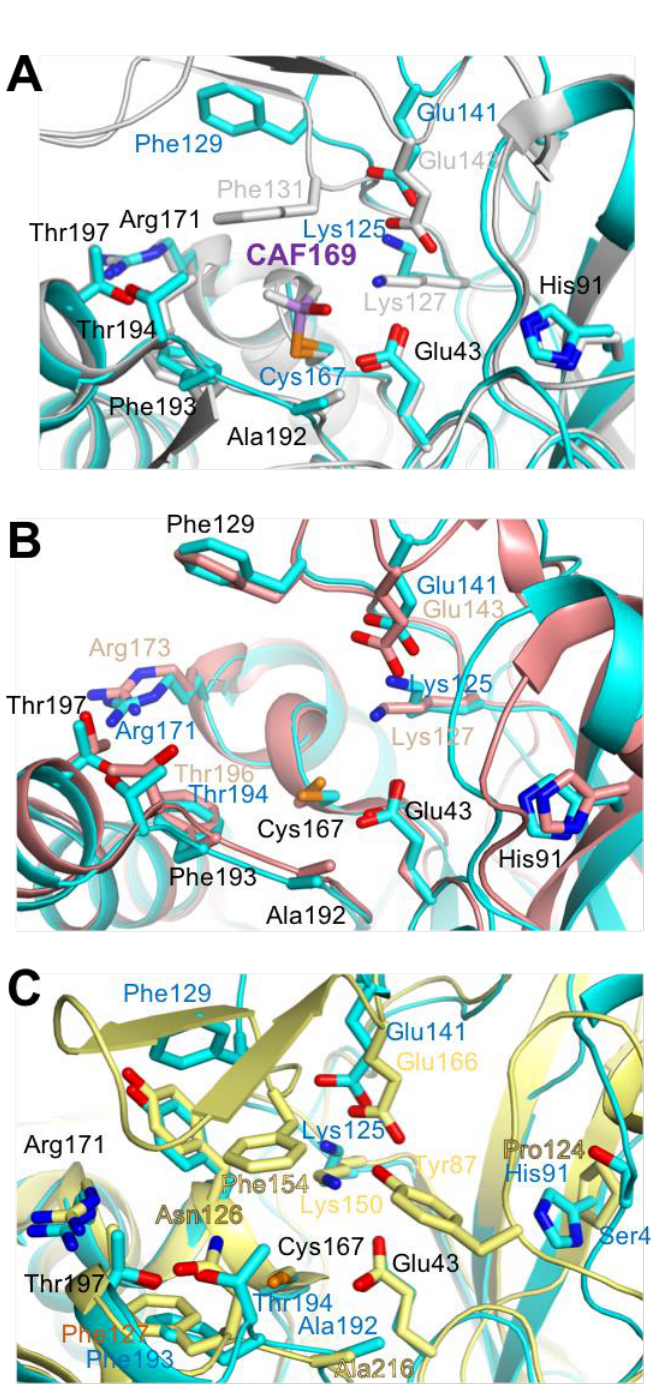
Figure 7. Comparison of the active sites. ( A ) Overlaid active sites of KlNit2 (cyan) and ScNit2 (gray). Residues with less varied conformations are numbered based on KlNit2 in black. Residues in distinct conformations are labeled by correspondence structures and colors. The S-dimethylarsinoyl-cystein from ScNit2 is in purple with an annotation. ( B ) Overlaid active sites of KlNit2 (cyan) and cNitFhit (salmon). Residues with less varied conformations are numbered based on KlNit2 in black. Residues in distinct conformations are labeled by correspondence structures and colors. ( C ) Overlaid active sites of KlNit2 (cyan) and MmNit2 (yellow). Residues with less varied conformations are numbered based on KlNit2 in black. Residues in distinct conformations are labeled by correspondence structures and colors. The figures were generated using the graphics program PyMOL (Schrödinger Inc., New York, NY,